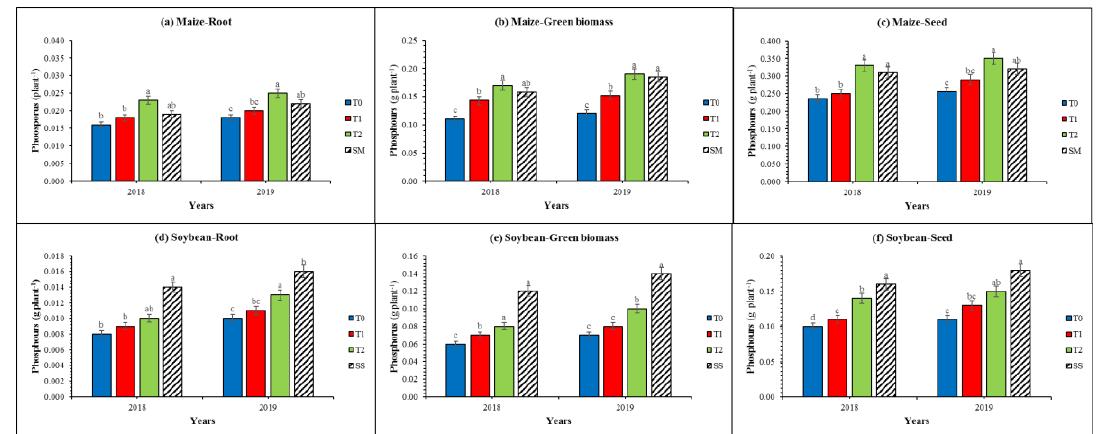
Figure 5. Root, green biomass and grain phosphorus content of maize ( a – c ) and soybeans ( d – f ) as a ff ected by di ff erent potassium treatments in the maize–soybean intercropping system (MSI) from 2018 to 2019 growing season. The T 0 , T 1 and T 2 represent the no potassium treatment, 40:30 kg ha − 1 and 80:60 kg ha − 1 , respectively, in MSI. The SS and SM refer to sole cropping system of soybeans and maize, respectively. Means are averaged over three replicates ± standard error. Means do not share the same letters in the column di ff er significantly at p ≤ 0.05.